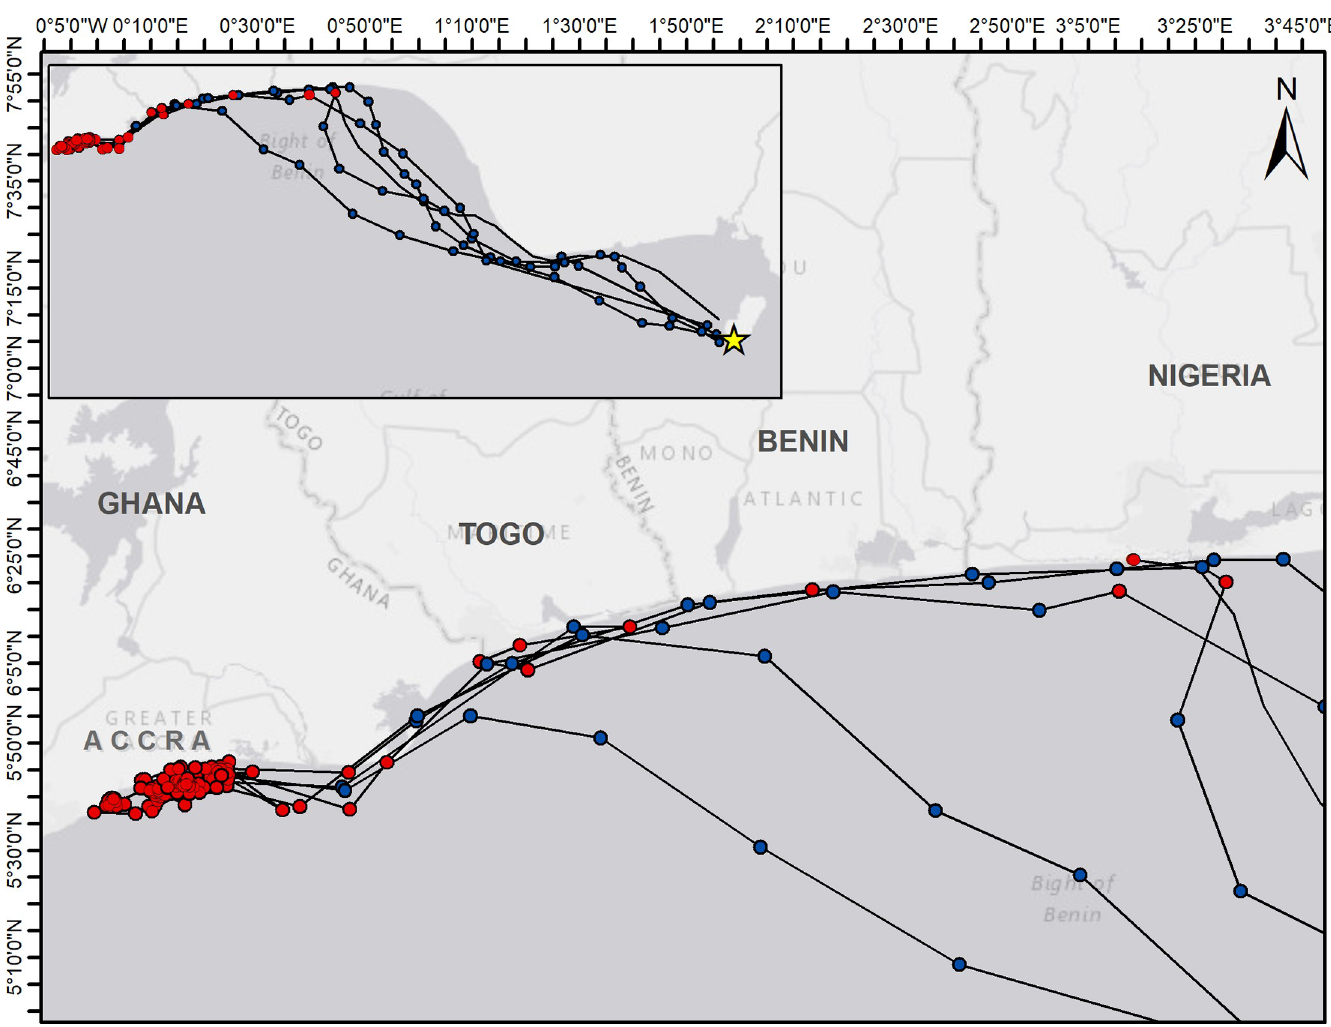
Fig 3. Daily locations (circles) of six turtles tracked from Bioko Island after the 2017–18 nesting season. Blue circles indicate transiting behavior and red circles indicate foraging behavior, as identified by the state space model. Three turtles exhibited migrations interspersed with short ( < 6 days) periods of foraging, while two exhibit direct migrations, followed by an extended period of foraging. Service Layer Credits: Esri, HERE, Garmin, GEBCO, NOAA NGDC, and other contributors OpenStreetMap contributors, and the GIS user community.